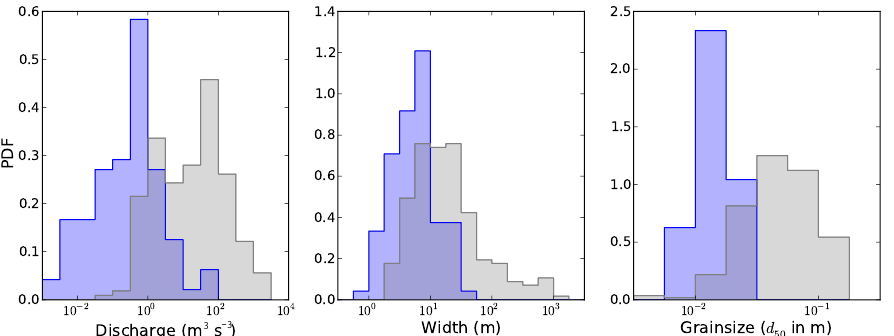
Figure 6. Normalized histograms (probability density function) of water discharge, width and grain size. Blue: this study; gray: GBR (gravel bed river) data set (Church and Rood, 1983; Parker et al., 2007; King et al., 2004; Ashmore,